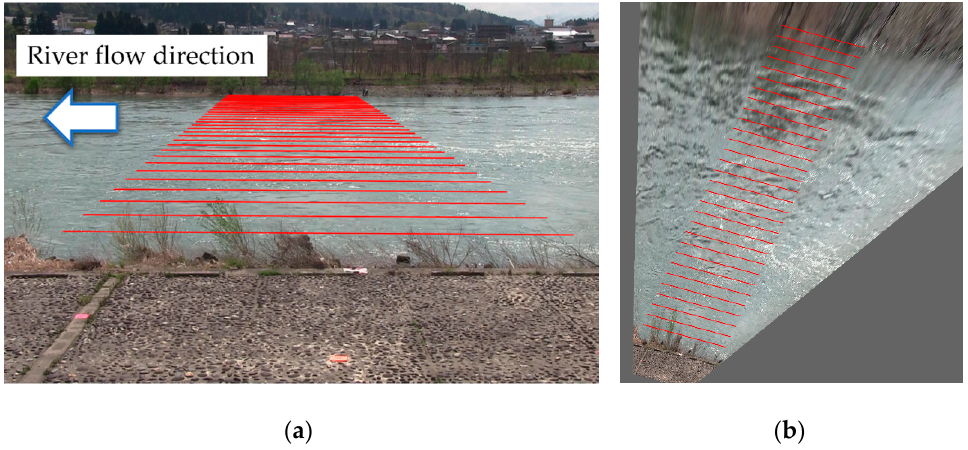
Figure 1. Original and orthorectified images with search lines: ( a ) original; ( b ) orthorectified